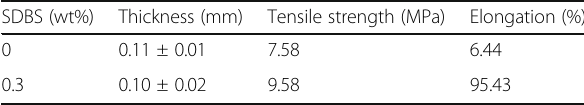
Table 2 Mechanical properties of PVA nanofiber membranes without and with